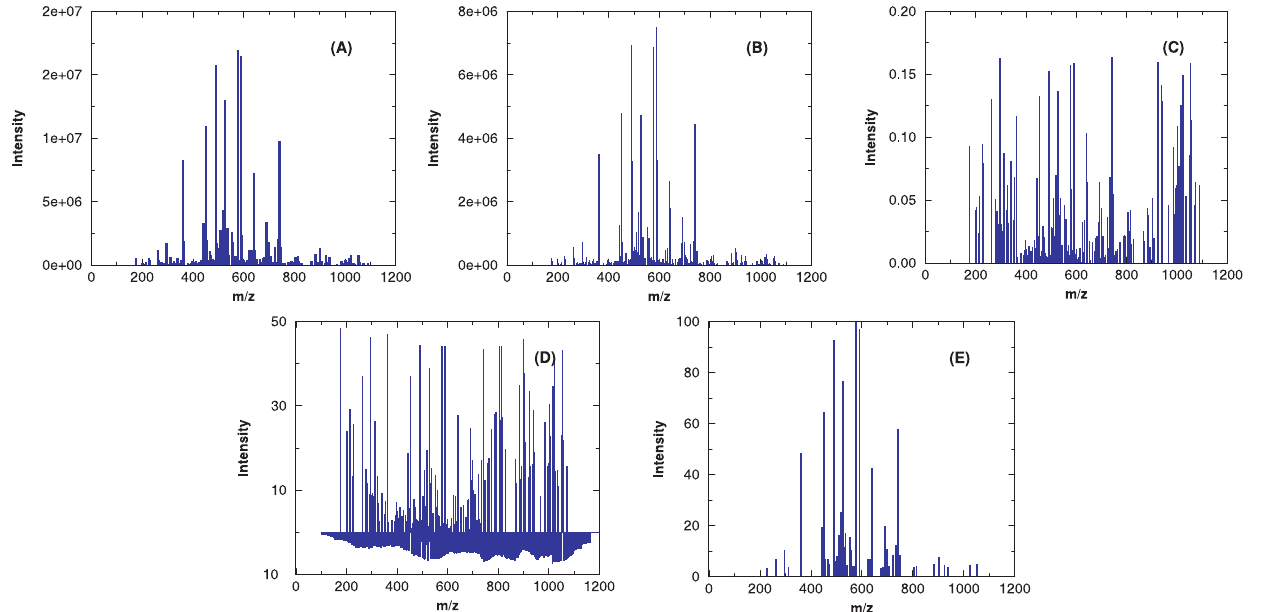
Figure 2. Example processed spectra from different scoring functions versus the original spectrum. The centroid spectrum used has a parent ion mass of 1640 : 80 Da. In panel (A), the original spectrum is displayed; (B) shows the processed spectrum generated by the filtering protocol of RAId_DbS scoring function; (C) exhibits the processed spectrum generated by the filtering protocol of K-score; while (D) and (E) correspond respectively to the processed spectra produced by XCorr and Hyperscore.